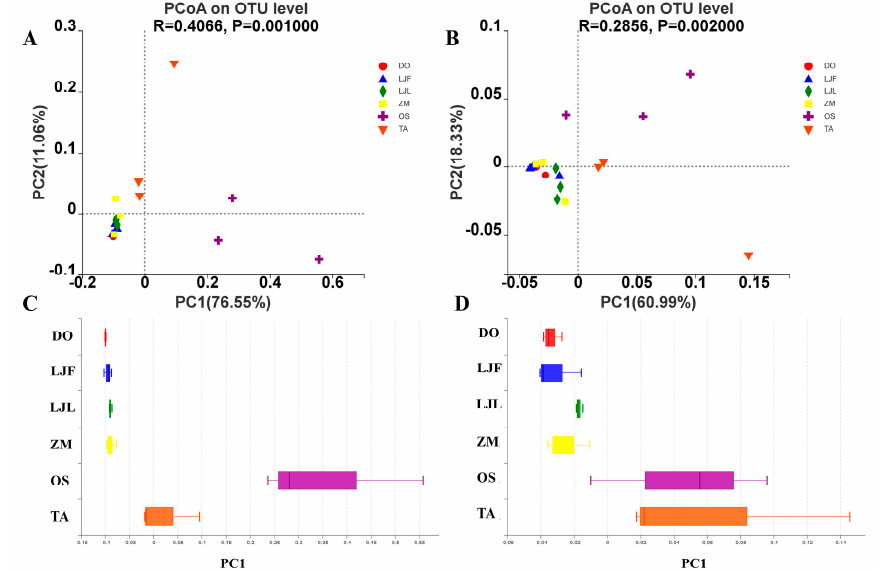
Figure 4. Principal coordinate analysis (PCoA) between different treatments. ( A , C ) based on the Bray − Curtis algorithm; ( B , D ) based on the weighted Unifrac algorithm. Abbreviations in the figure represent different treatments: ZM, maize; TA, wheat; OS, rice; LJF, honeysuckle flowers; LJL, honeysuckle leaves; and DO, Chinese yam.